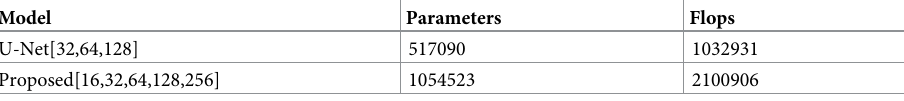
Table 2. Related parameters to our model and